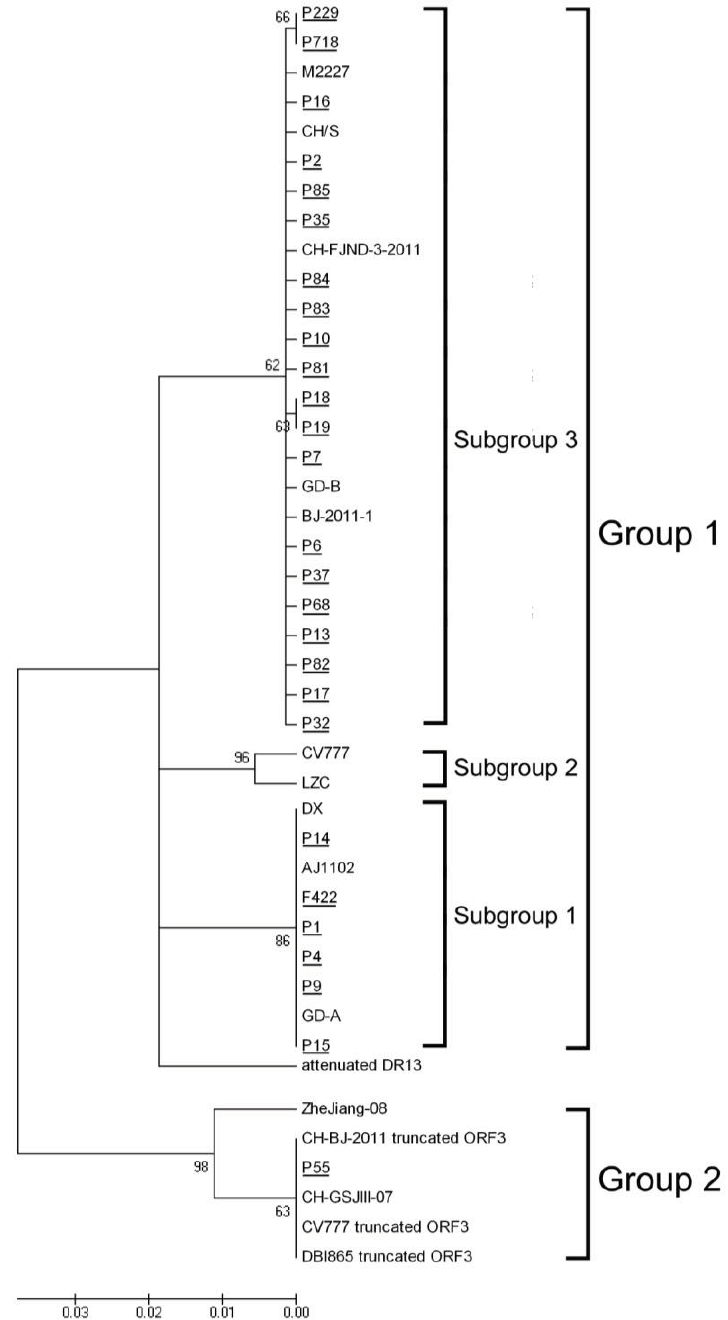
Figure 3. Phylogenetic tree of the nucleotide sequences of PEDV samples based on the ORF3 gene. Sequences of reference strains were obtained from the GeneBank